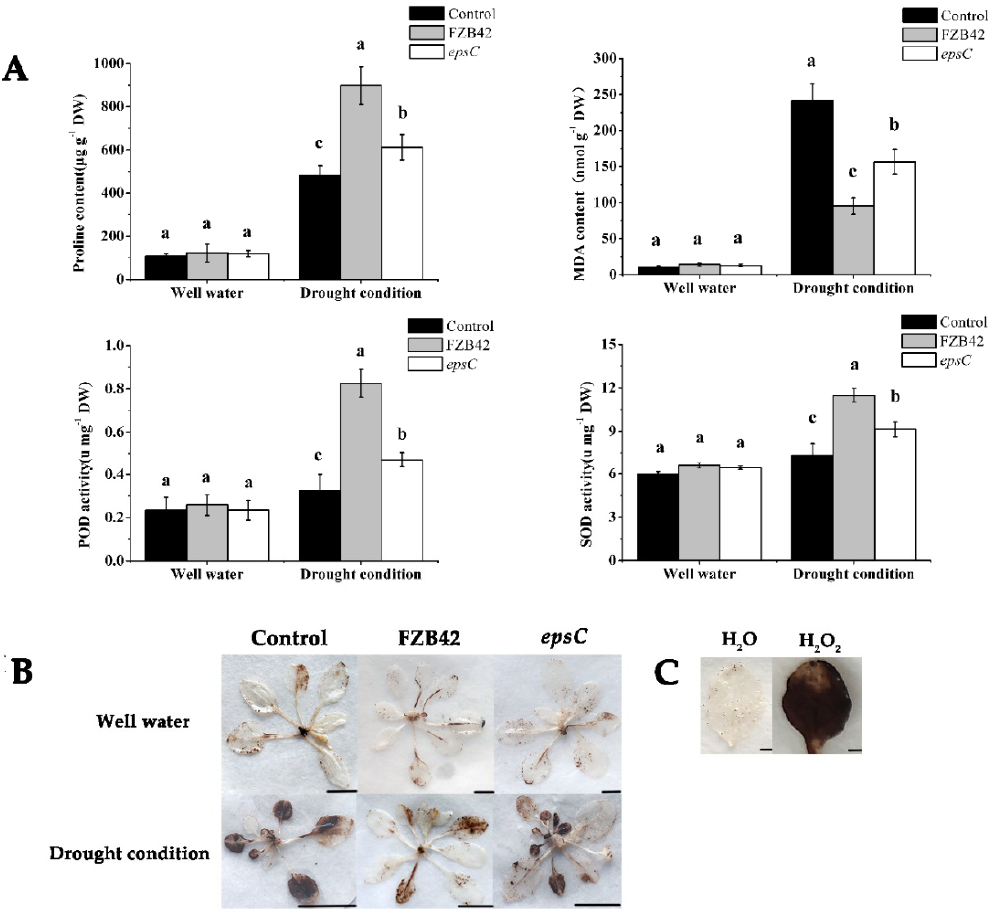
Figure 2. The biochemical response of the A. thaliana leaf to drought stress. The concentration of proline and malondialdehyde (MDA), and the activity of superoxide dismutase (SOD) and peroxidase (POD) ( A ), 3,3-diaminobenzidine staining revealing the accumulation of hydrogen peroxide in well-watered and droughted plants inoculated with either wild type FZB42 or the epsC mutant. Scale bar, 1 cm ( B ), 3,3-diaminobenzidine staining revealing the accumulation of hydrogen peroxide in wild type Arabidopsis leaves treated with H 2 O or 20 mM H 2 O 2 . Scale bars, 1 mm ( C ). Values in ( A ) are shown as means, with the whiskers representing the standard error (SE, n = 18). Different letters above each column indicate statistically significant ( p < 0.05) differences in mean performance.